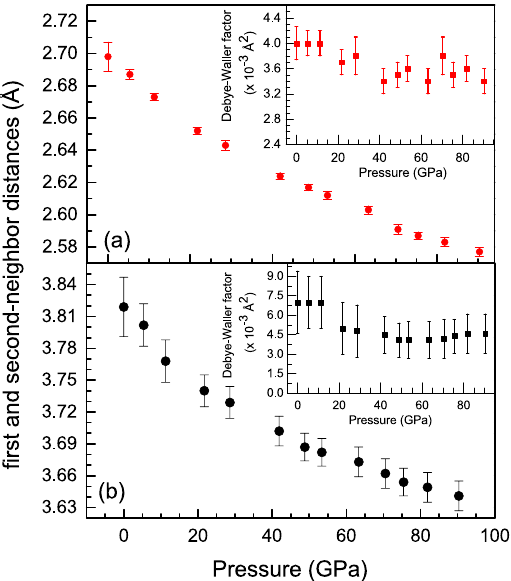
Figure 5. ( a ) Pressure evolution of the nearest-neighbor distances and ( b ) second-neighbor distances. The Debye-Waller (DW) factors that correspond to the first and second shell are represented in the